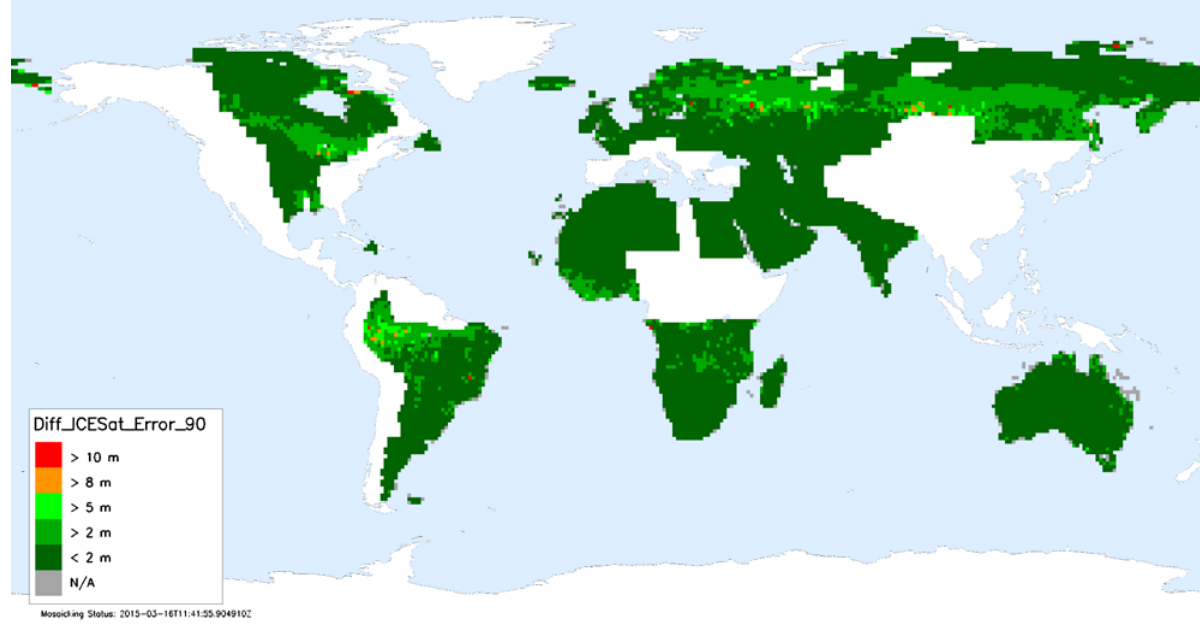
Figure 6. Global map showing 90% absolute height accuracy per final DEM tile in meter (status February